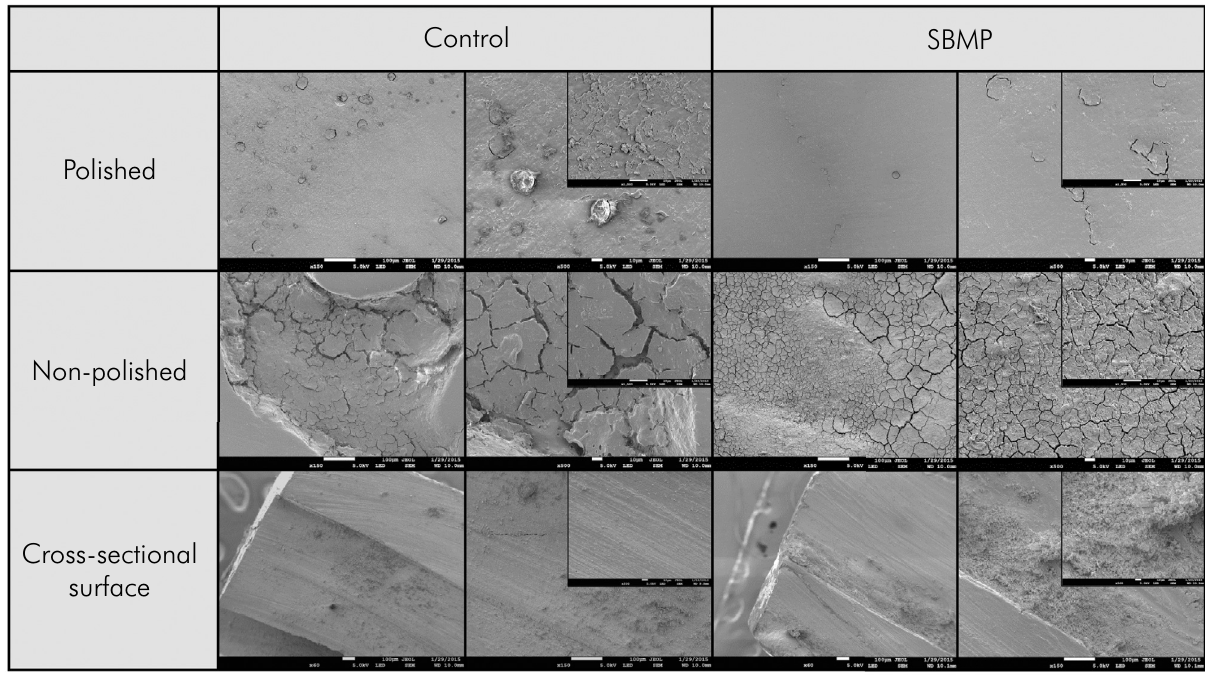
Figure 3. SEM images of the external and cross-sectional surfaces of the polished and non-polished specimens, with (SBMP) or without (control) modeling liquid, after 12 months of red wine